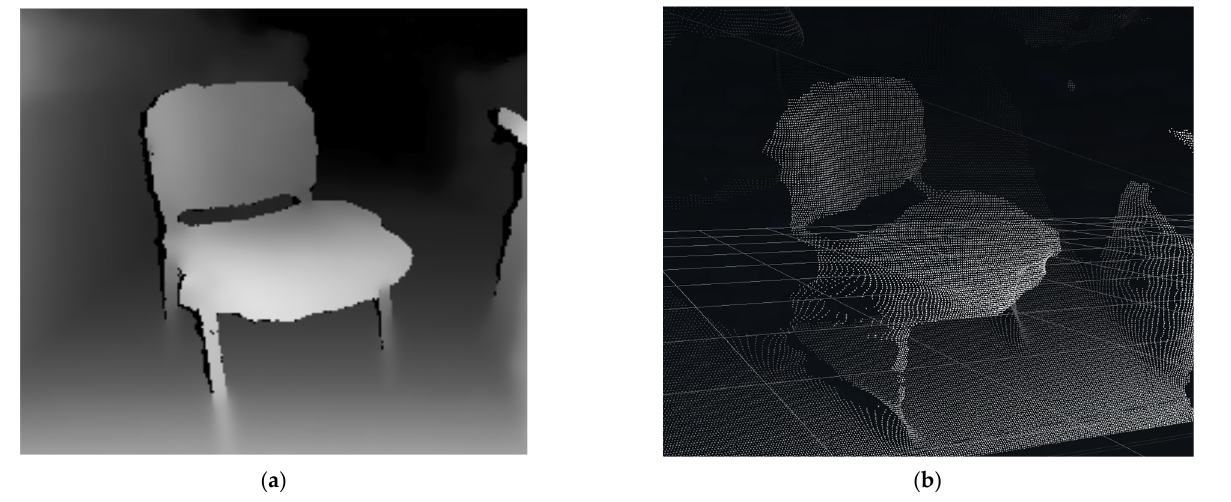
Figure 2. 3D chair data: ( a ) depth image; ( b ) point cloud.